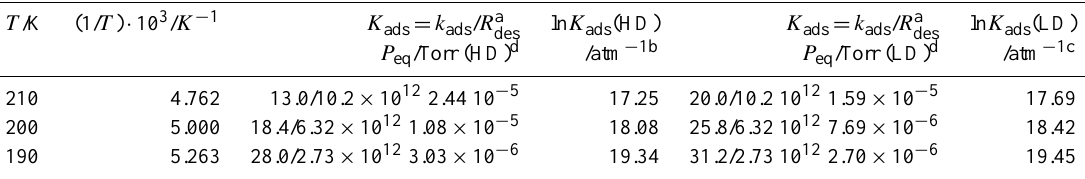
− 1 with k − 1 and R − 3 s − 1 (Flückiger et al., 1998). a ( k 19 = K ads / R des ) · 2.44 × 10 ads /atm ads /s des /moleccm b K 15 molecule/pulse and higher. Corresponding thermochemical ads (HD) = ( k ads / R des ) in units of atm, where k ads is for high dose (HD) of typically 5 × 10 parameters are 1 H 0 r =− 34.80kJmol − 1 and 1 S r =− 22.87Jmol − 1 K. c K 14 moleculepulse − 1 . Corresponding thermochemical ads (LD) = ( k ads / R des ) in units of atm, where k ads is for low dose (LD) of typically 5 × 10 parameters are 1 H